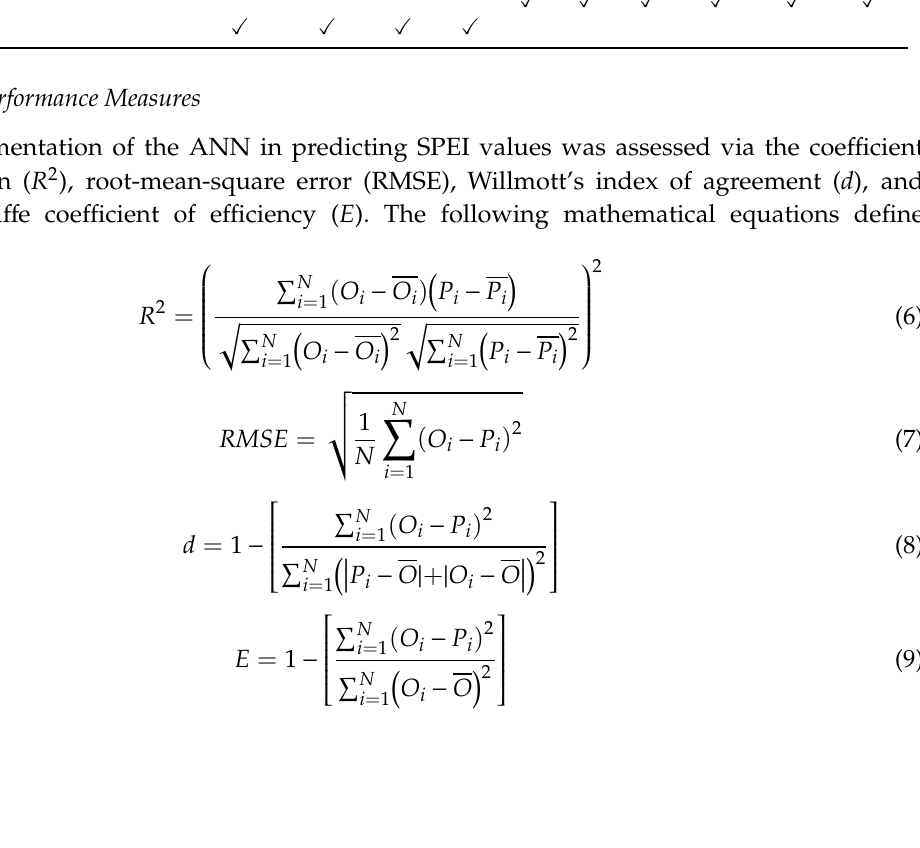
Table 3. Input variables proposed in the search for suitable models for predicting SPEI.